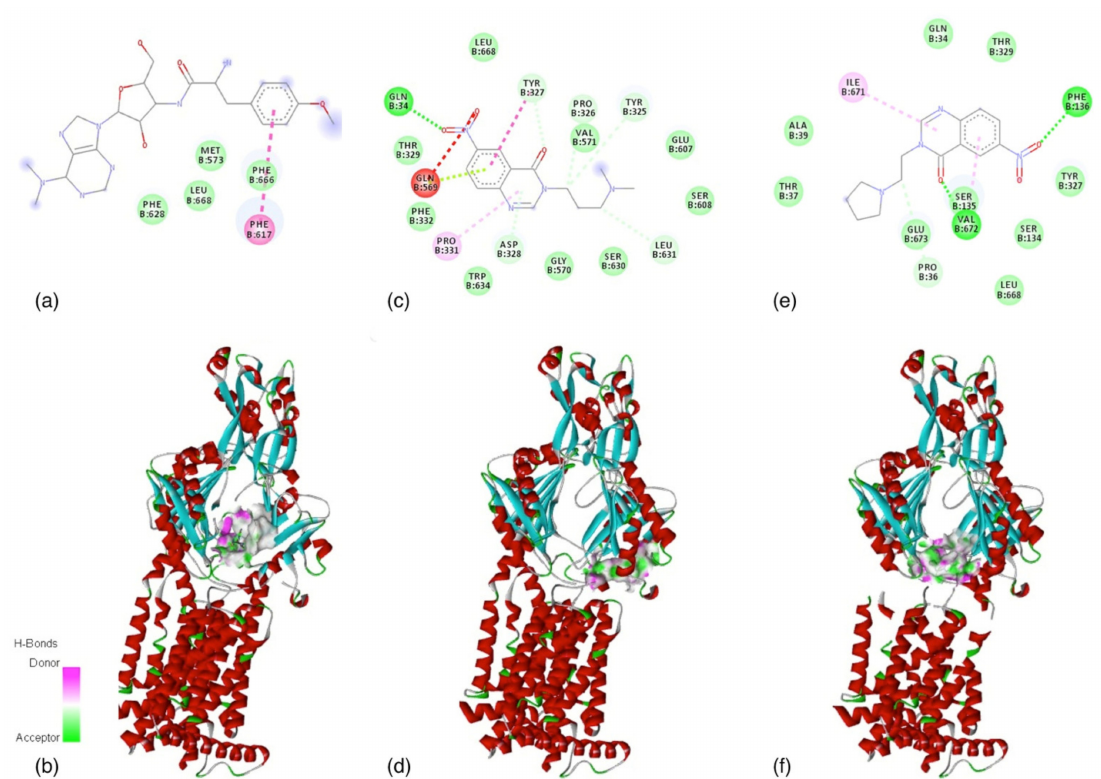
Figure 1. AcrB subunit of the multidrug efflux pump chain B (PDB code: 5NC5). (i) Experimental data—( a ) AA in close contact with puromycin (antibiotic crystallized with the protein); ( b ) puromycin allosteric binding situs. (ii) Predicted data—( c , e ) AA in close contact with BG1189 respectively BG1190; ( d , f )—BG1189 respectively BG1190 interacting with pore domains of AcrB subunit. ( a , c , e ) Light green: van der Waals interactions; green: conventional hydrogen bond, grey: carbon hydrogen bond; red: unfavorable acceptor–acceptor interaction; dark pink: Pi–Pi T-shaped interaction; light pink: Pi–Alkyl interactions; ( b , d , f ) alpha helices of the protein are represented in red color, beta sheets in blue, turns in green, and random coil in grey. Images were obtained using Discovery Studio Visualizer [36].